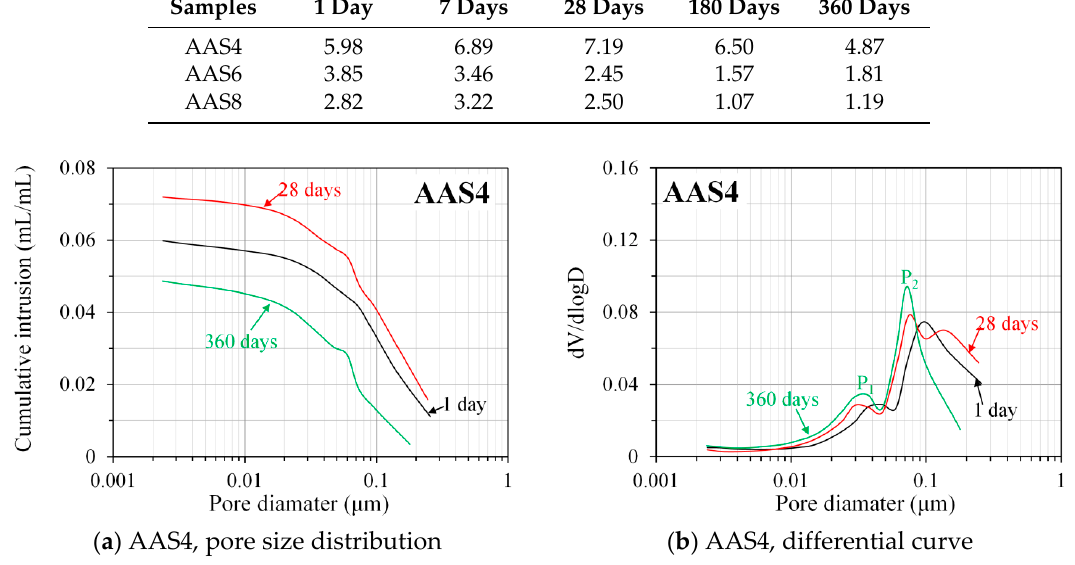
Table 3. Porosity (%) of small pores (<0.25 μ m) derived from nitrogen adsorption. Samples